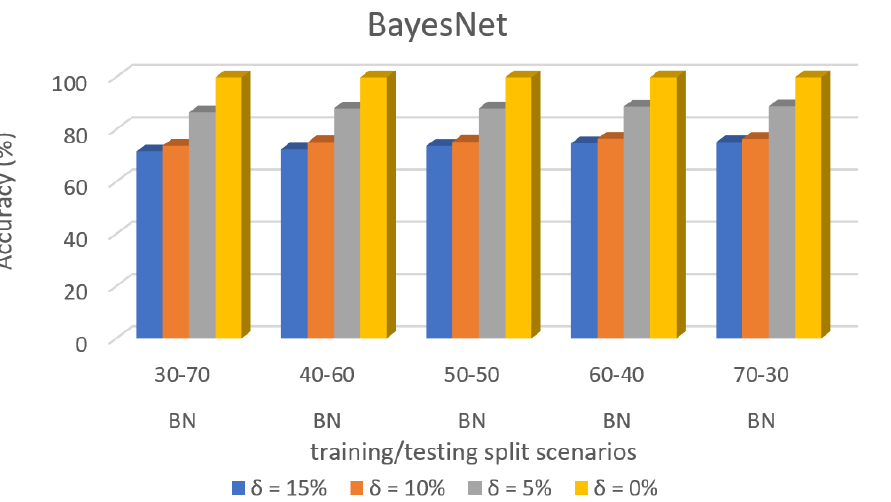
Figure 8. Accuracy Prediction for Dataset 1 using Bayesian Network Algorithm.